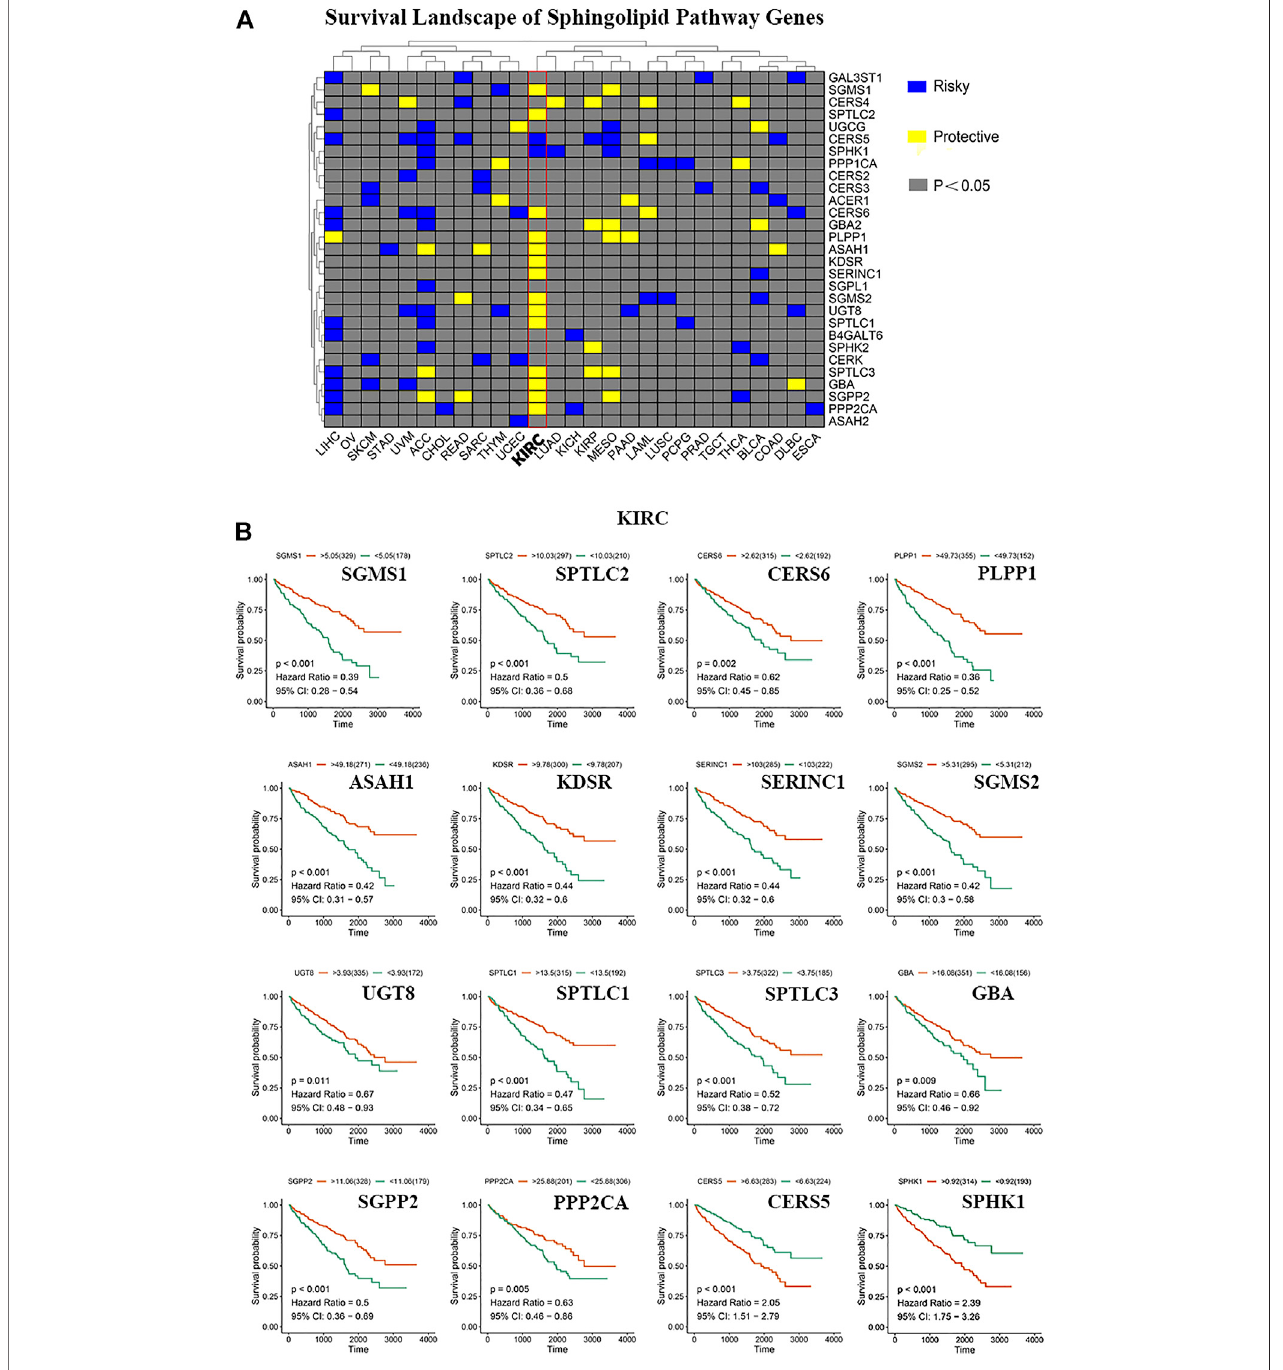
FIGURE 3 | The role of sphingolipid pathway genes in cancer. (A) Survival map of sphingolipid genes. Blue represents risk genes and yellow represents protective genes. The gray bar represents no statistical signi fi cance. (B) The survival curve of sphingolipid pathway genes in kidney renal clear cell carcinoma (KIRC). We selected 16 meaningful genes based on the survival map. According to the best cutoff value, the samples are divided into high-expression groups and low-expression groups, and the associated survival curve is drawn. The orange line represents the high-expression groups, and the green line represents the low-expression groups. The abscissa represents the number of days, and the ordinate represents the survival probability.